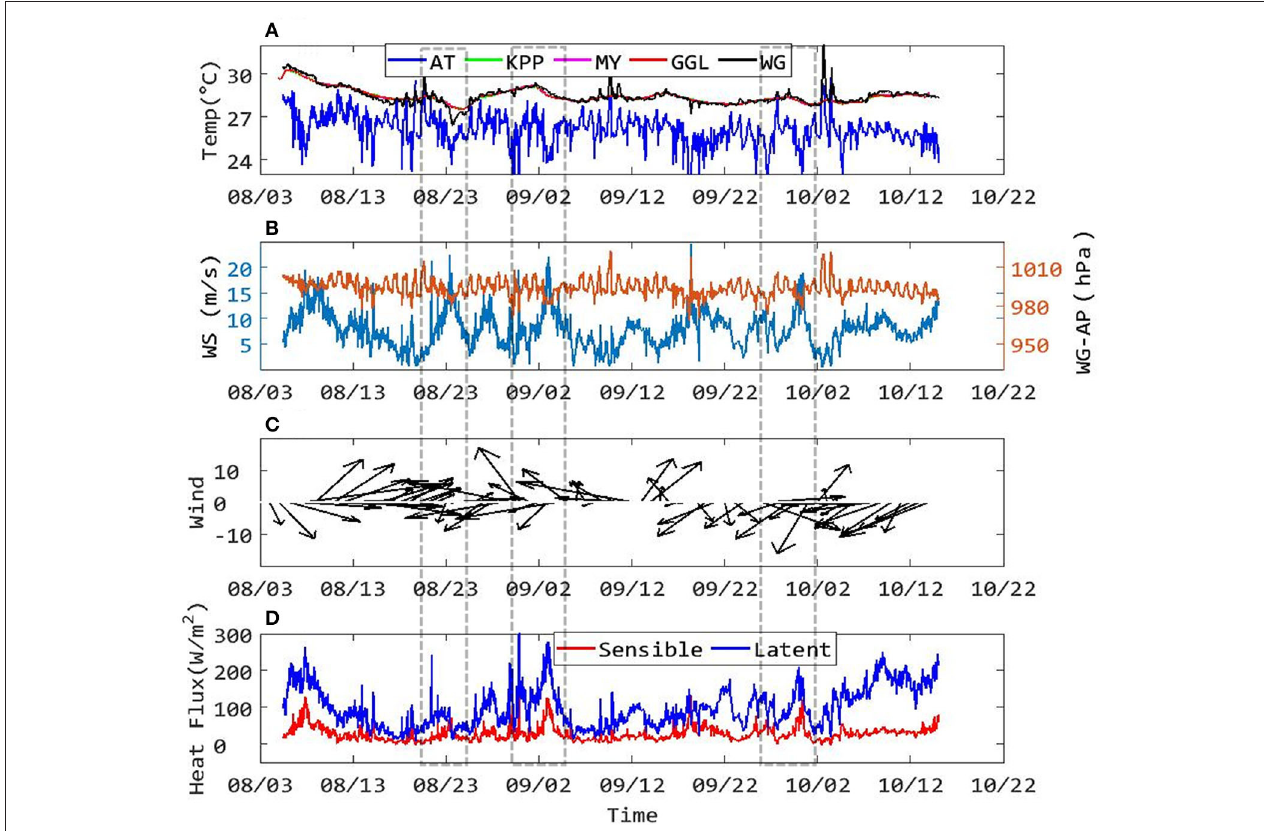
FIGURE 2 | Time serial of wave glider observed (A) SST and air temperature (blue line), (B) magnitude of wind speed (cyan) and air pressure (yellow), (C) wind vector, and (D) turbulent heat fluxes calculated from COARE 3.0 algorithm. The red, pink, and green lines in (A) are model results from K-Profile Parameterization, Mellor-Yamada Turbulence Closure Model, and Gaspar-Grégoris Lefevre Turbulent Closure Scheme. The blue and red lines in (f) are latent and sensible heat fluxes, respectively. The gray boxes are periods of TCs Bailu, Lingling, and Mitag. TCs, tropical cyclones; SST, sea surface temperature.